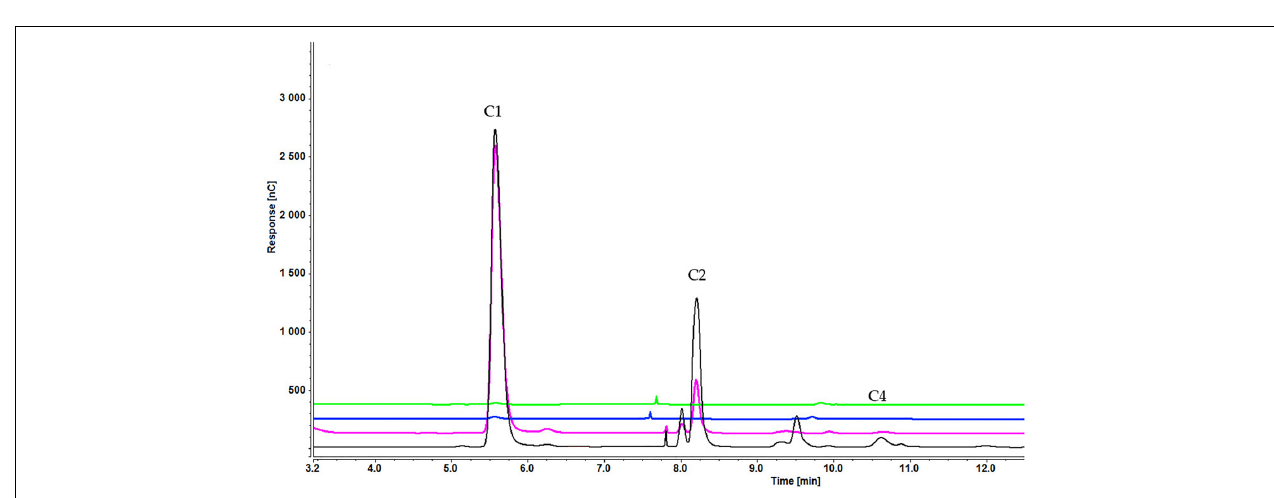
FIGURE 11 | Cellooligosaccharides concentration in the medium after 1 h (black), 3 h (pink), 5 h (blue), and 7 h (green) of induction with 0.3% cellobiose (C1 = glucose, C2 = cellobiose). Figures for 0.1% ( Supplementary Figure S5A ) and 0.2% cellobiose ( Supplementary Figure S5B ) is presented in Supplementary Material